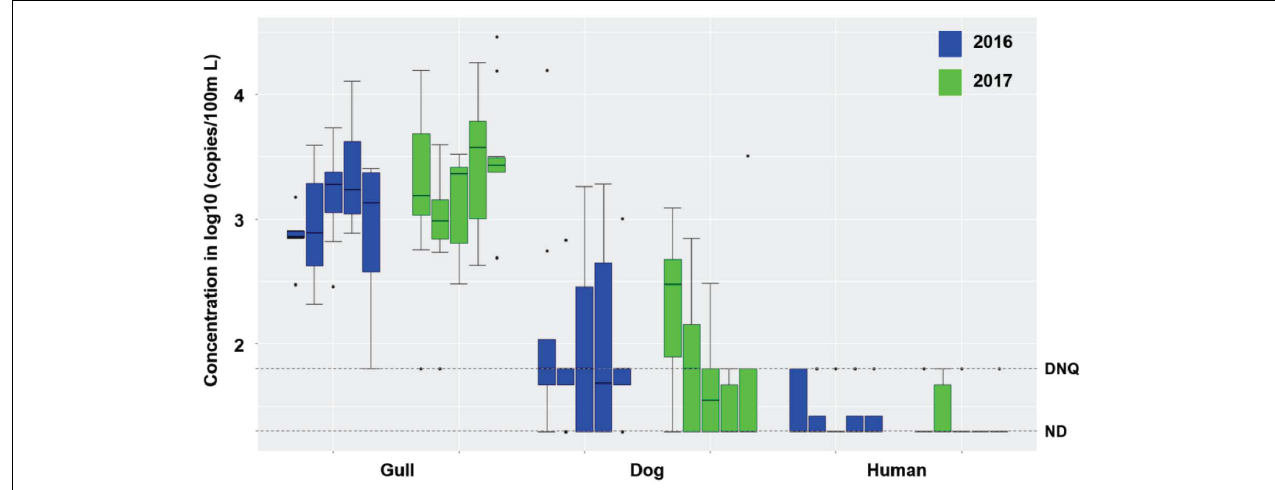
FIGURE 1 | Boxplots of gull, dog and HF183 human fecal marker concentrations in surf zone waters collected from 5 sites (G01-G05, from left to right in each set of boxes) of GB in 2016 (8 samples per site and 40 samples in total) and 2017 (10 samples per site and 50 samples in total) during dry weather ( Supplementary Table 1 ). DNQ (1.8 on log10 scale) and ND (1.3 on log10 scale) levels are shown in the figure as dotted